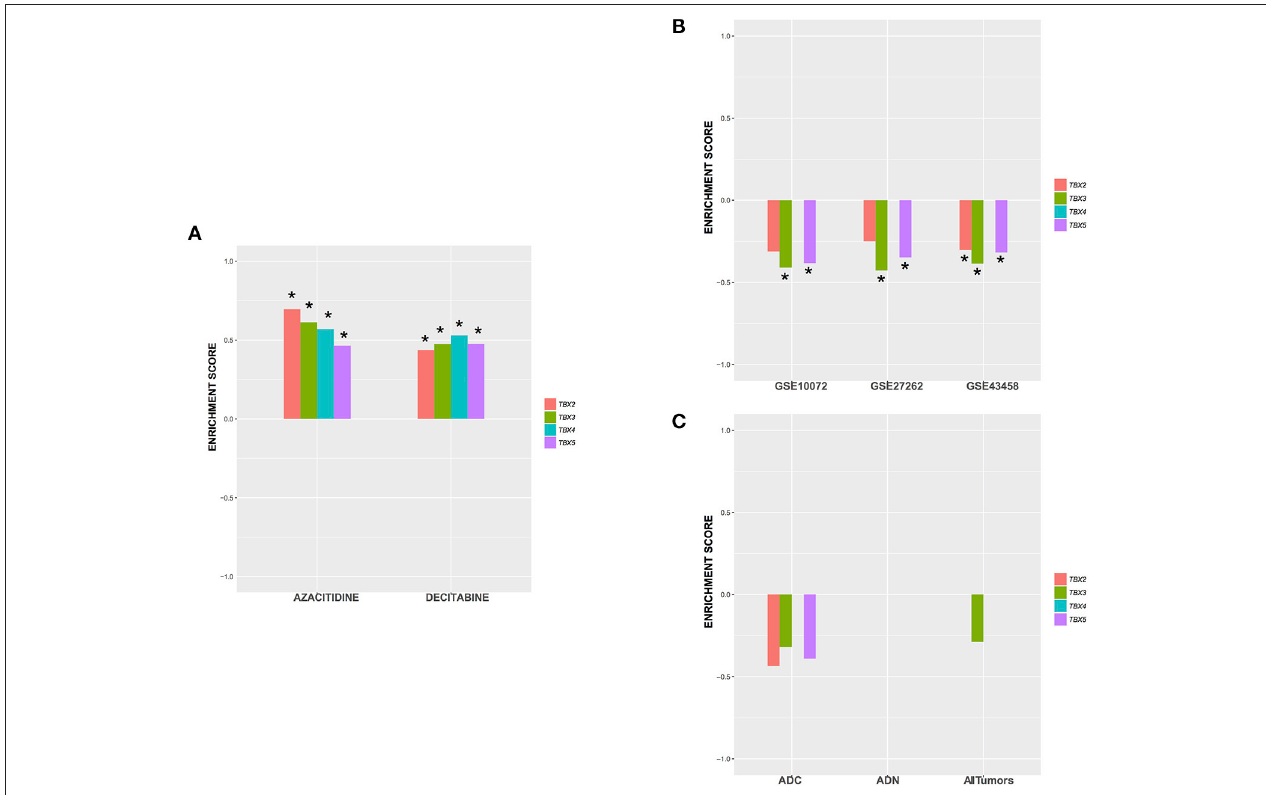
FIGURE 6 | Enrichment score of the top 75up /75 down-regulated genes in all TBX settings against signatures from (A) NCI-H1299 cells treated with 2 demethylating agents (GSE29077), (B) 3 lung adenocarcinoma public datasets, and (C) mouse adenocarcinomas from Gprc5a knock-out mice. The plots show the enrichment score for each setting ∈ [ − 1,1]. A positive enrichment score suggests a similar mechanism of action while a negative one would suggest an opposite/dissimilar molecular perturbation. *Significance level ( p < 0.05). ADC, adenocarcinoma; AND,